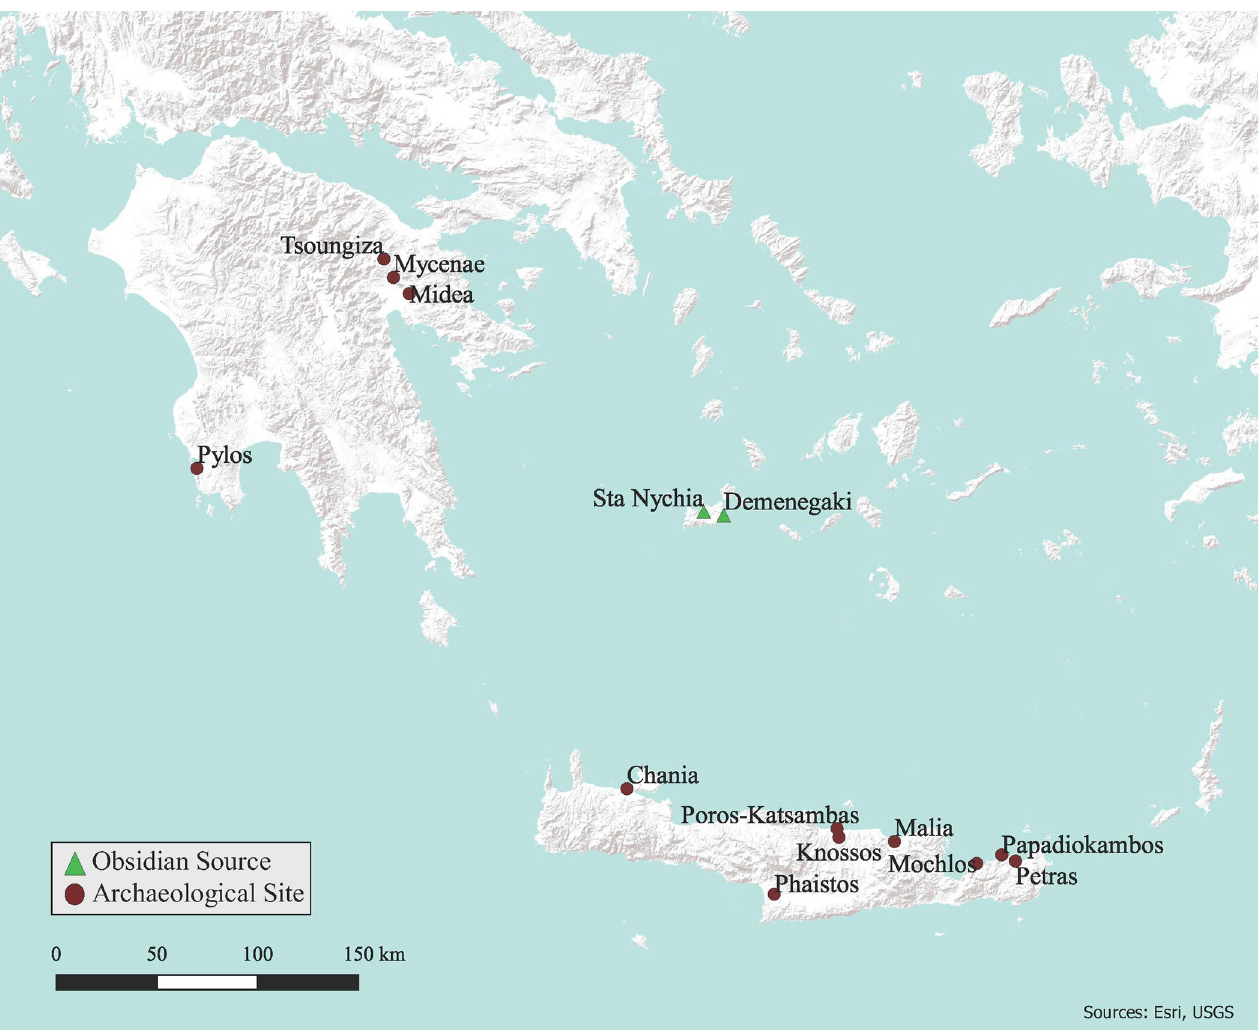
Fig 2. Map showing main sites mentioned in the text. Compiled in QGIS 3.16.3 using ESRI World Terrain base map, by C. Lopez. Original copyright with the authors.